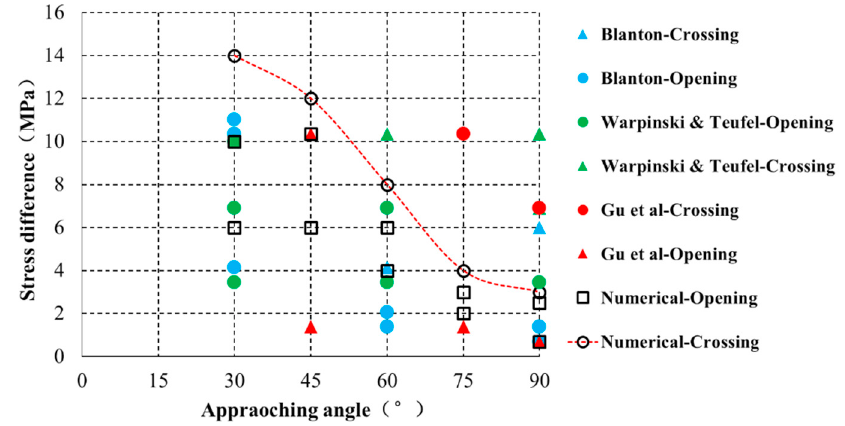
Figure 7. Comparison between numerical simulation and experimental results with different angles of approach and horizontal differential stresses.